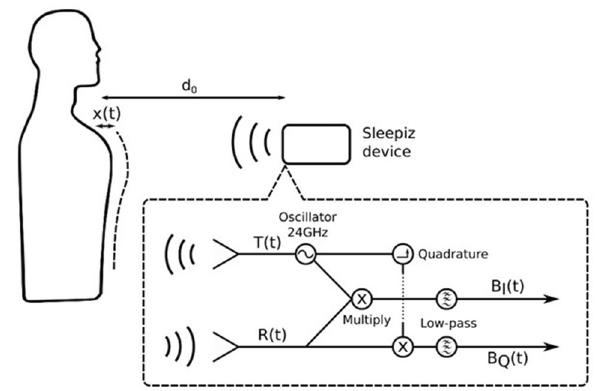
Figure 1. Schematic of radar operation. T(t) transmitted electromagnetic signal (f = 24 GHz), R(t) reflected signal, BI(t) in-phase channel, received signal multiplied by transmitted signal, low-pass filtered, BQ(t)